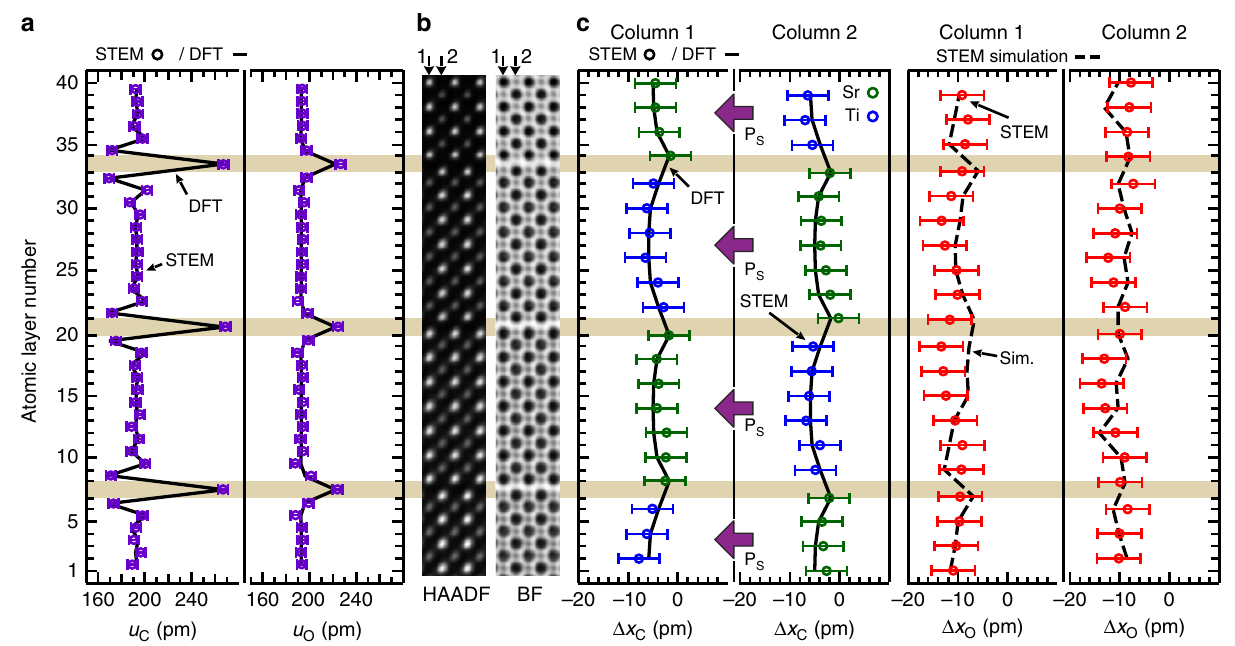
Sim.P P S P S Figure 3 | FE atomic columns in Sr 7 Ti 6 O 19 film region #1. ( a ) Cation u C and oxygen u O interatomic spacing (purple open circle) extracted from the drift-corrected HAADFand BF STEM images superimposed on the DFTcalculated values (solid grey line). The characteristic decrease in interplanar spacing in u C and its absence in u O adjacent to the rock salt layers (horizontal beige colour rectangles across the panels) indicates rumpling in the atomic structure due to the rock salt layer. Exceptional agreement between experiments and DFT is seen. ( b ) Average experimental HAADF and BF STEM slices from region #1 of the sample. The slices are repeated for clarity. ( c ) Cation D x C (blue and green open circles) and oxygen D x O (red open circles) displacements along the [100] PC taken from the drift-corrected HAADF and BF images along with the superimposed FE DFTcalculated positions (solid black line) and FE DFT simulated oxygen positions (dashed black lines). The simulated oxygen positions were performed with a 1.25mrad tilt about the [001] PC axis (the simulation with the best agreement to experiment). The error bars are taken to be the root mean s.e. from the positions of a best fit lattice determined by